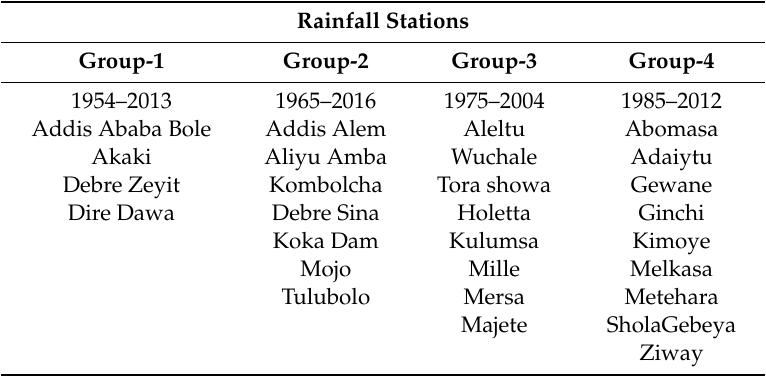
Table A3. Classification of Rainfall Stations in Awash River